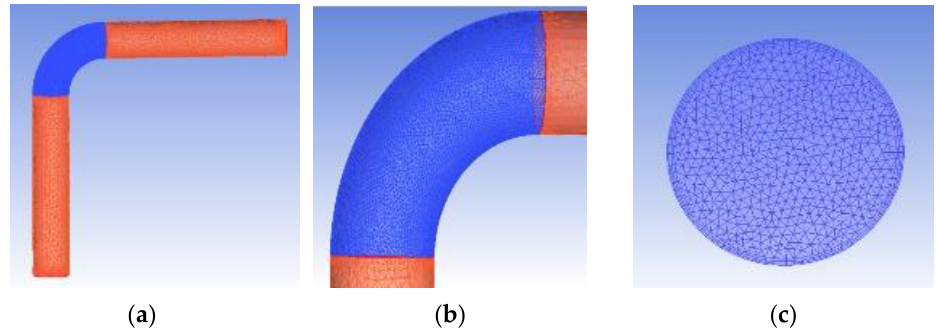
Figure 5. Mesh diagram. ( a ) Computing mesh; ( b ) Local mesh refinement; ( c ) Inlet cross-section.